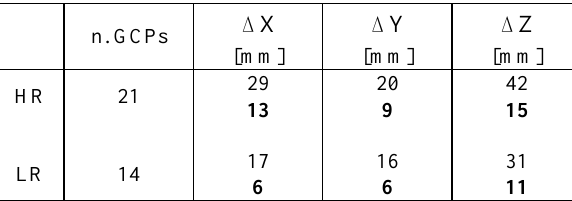
Table 9. Terrestrial photogrammetric block - GCPs residual errors along Vallone d'Elva road .